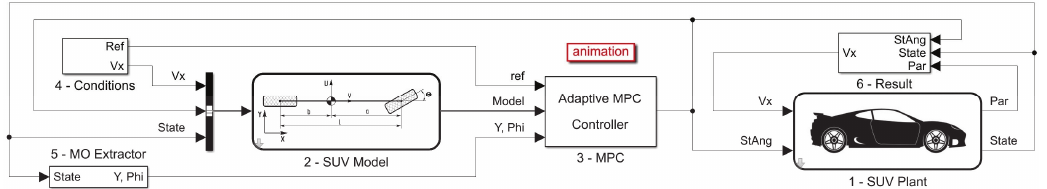
Figure 8. Simulink model of overtaking scenario execution.